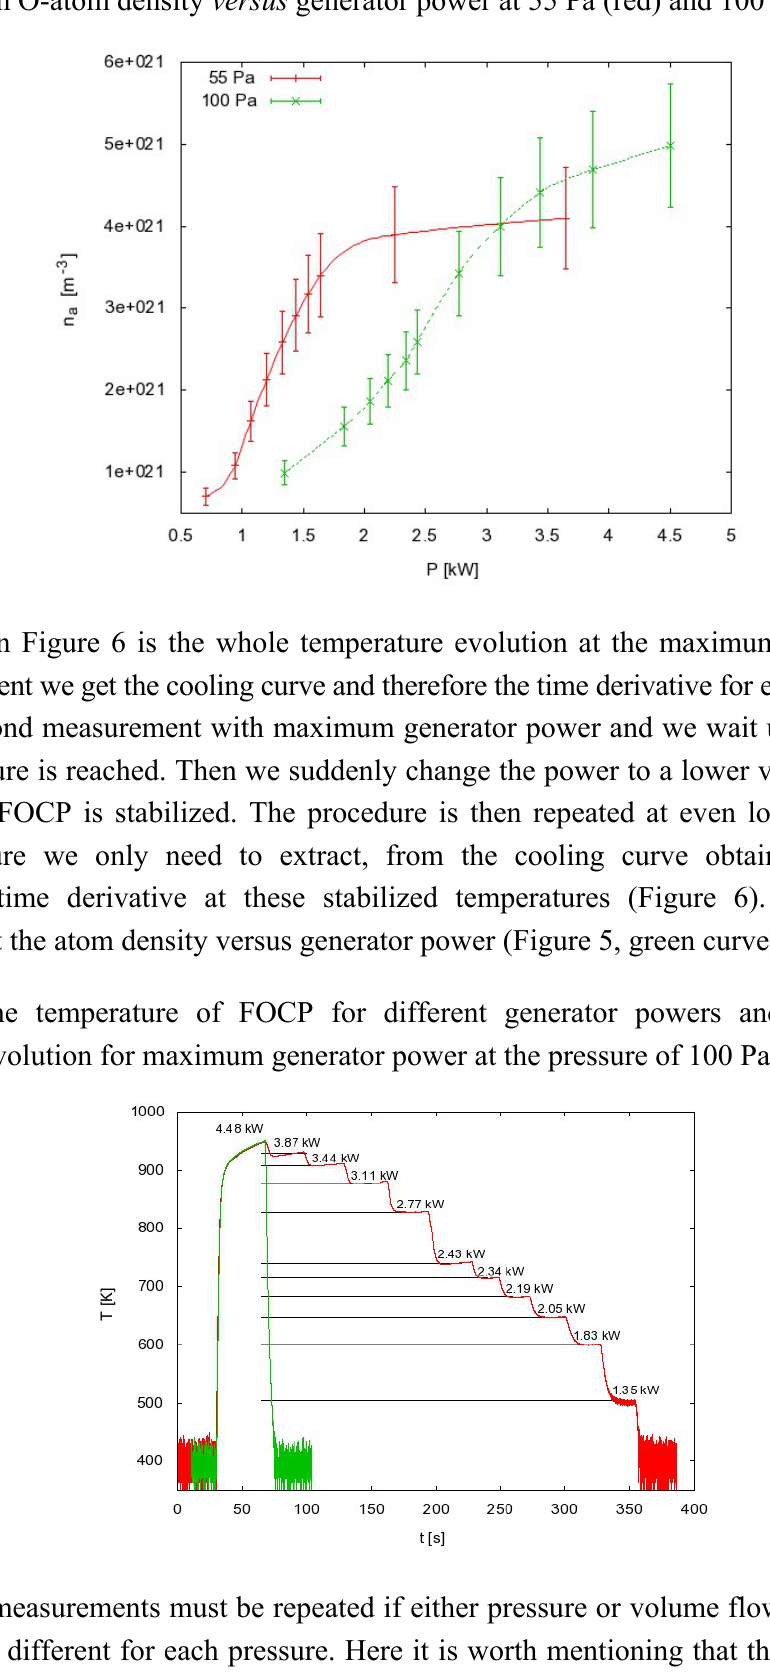
Figure 5. An O-atom density versus generator power at 55 Pa (red) and 100 Pa (green).